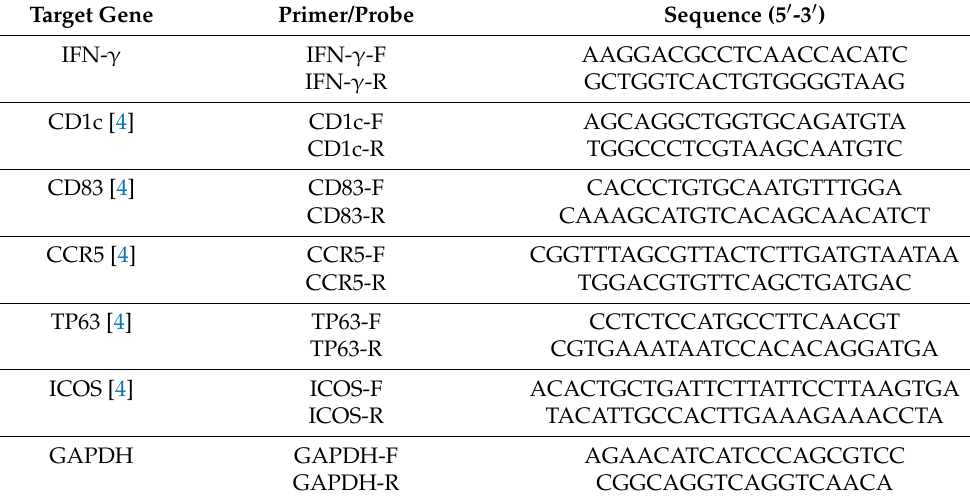
Table 1. Cont . Target Gene Primer/Probe Sequence (5 (cid:48) -3 (cid:48) ) IFN- γ IFN- γ -F